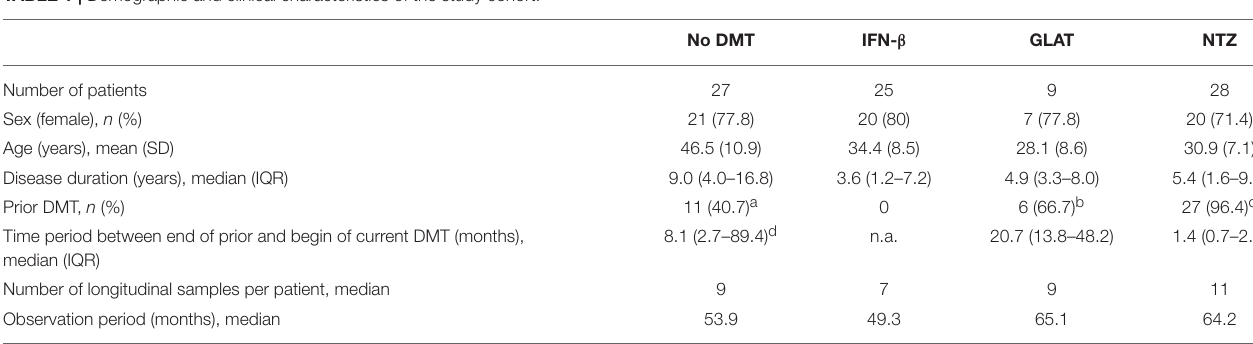
( Table S1 ) nor patients with stable anti-JCV antibody status ( Figure 2A , Table S2 ) or stable positive anti-JCV antibody status ( Table S3 ). The median CV of anti-JCV AI in patients with stable anti-JCV antibody status was 14.4% ( Table 2